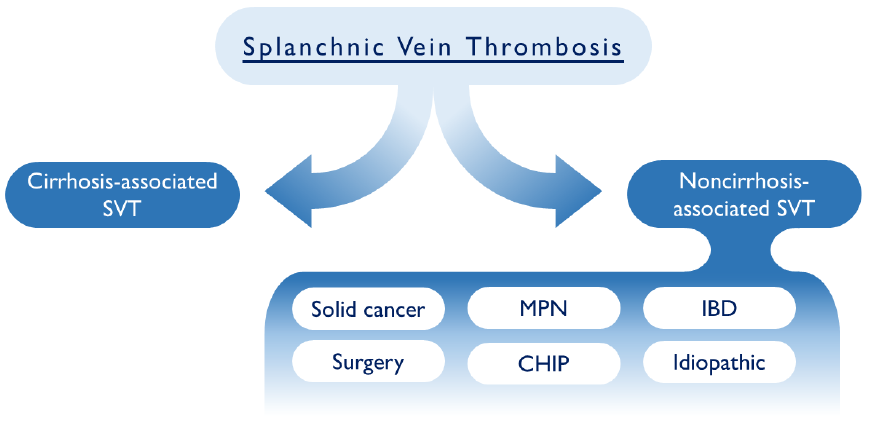
Figure 1. Schematic representation of SVT classification. MPN: myeloproliferative neoplasms, IBD: inflammatory bowel disease; CHIP: clonal hematopoiesis of indeterminate potential.